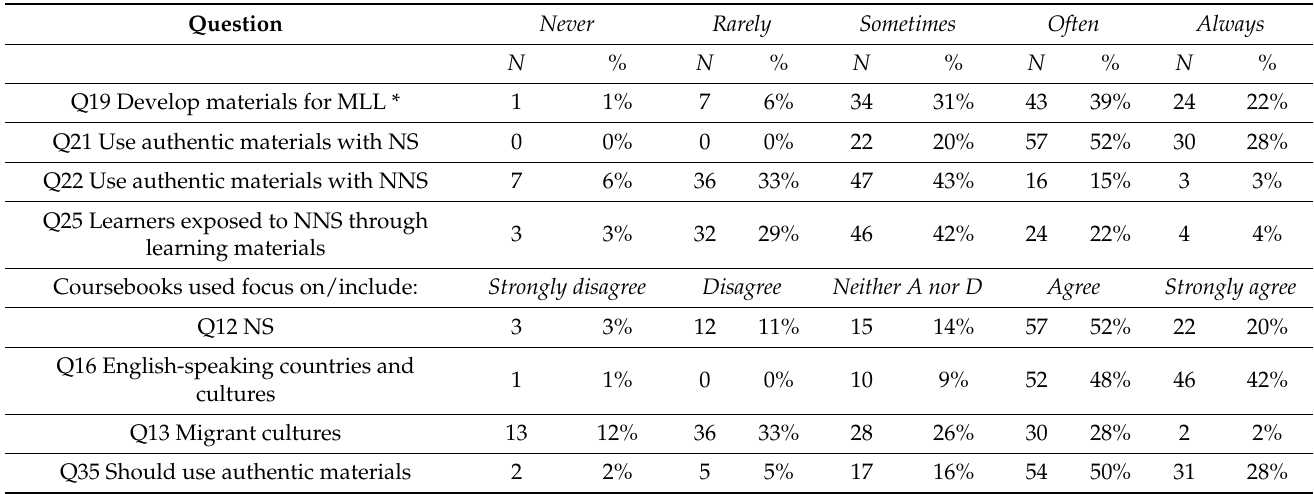
Table 5. Teachers’ reported practices for English use in teaching materials and